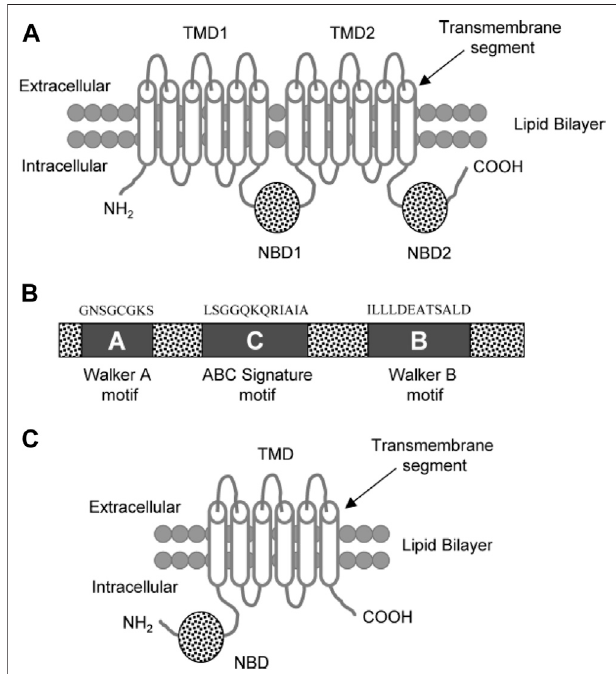
FIGURE 6 | (A) Diagram of a typical ABC transporter protein inserted in the lipid bilayer. The trans-membrane protein consists of 2 trans-membrane domains(TMDs) and the twonucleotideATPbindingdomains (NBDs) (B) The NBDs consists of walker A, walker B, and ABC signature C motifs with characteristic residues of the respective amino acid sequences above these motifs. (C) ABCG2 diagram showing a half transporter (6 trans-membrane segments and 1 NBDs) at the N-terminal end (Choudhuri and Klaassen,